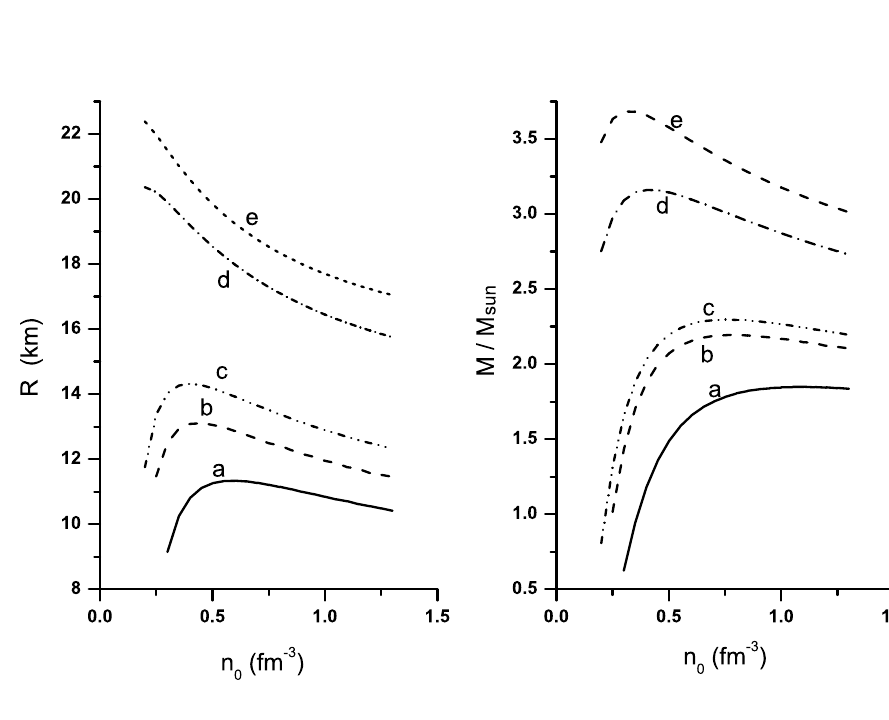
Figure 1. Radius(left) and mass(right) of the star as functions of the baryon density at the star’s center under di ff erent temperatures. (a)T = 2 MeV, (b) same as (a), but without s quarks,(c)T = 20 MeV, (d)T = 40 MeV, (e) same as (d), but without s quarks.